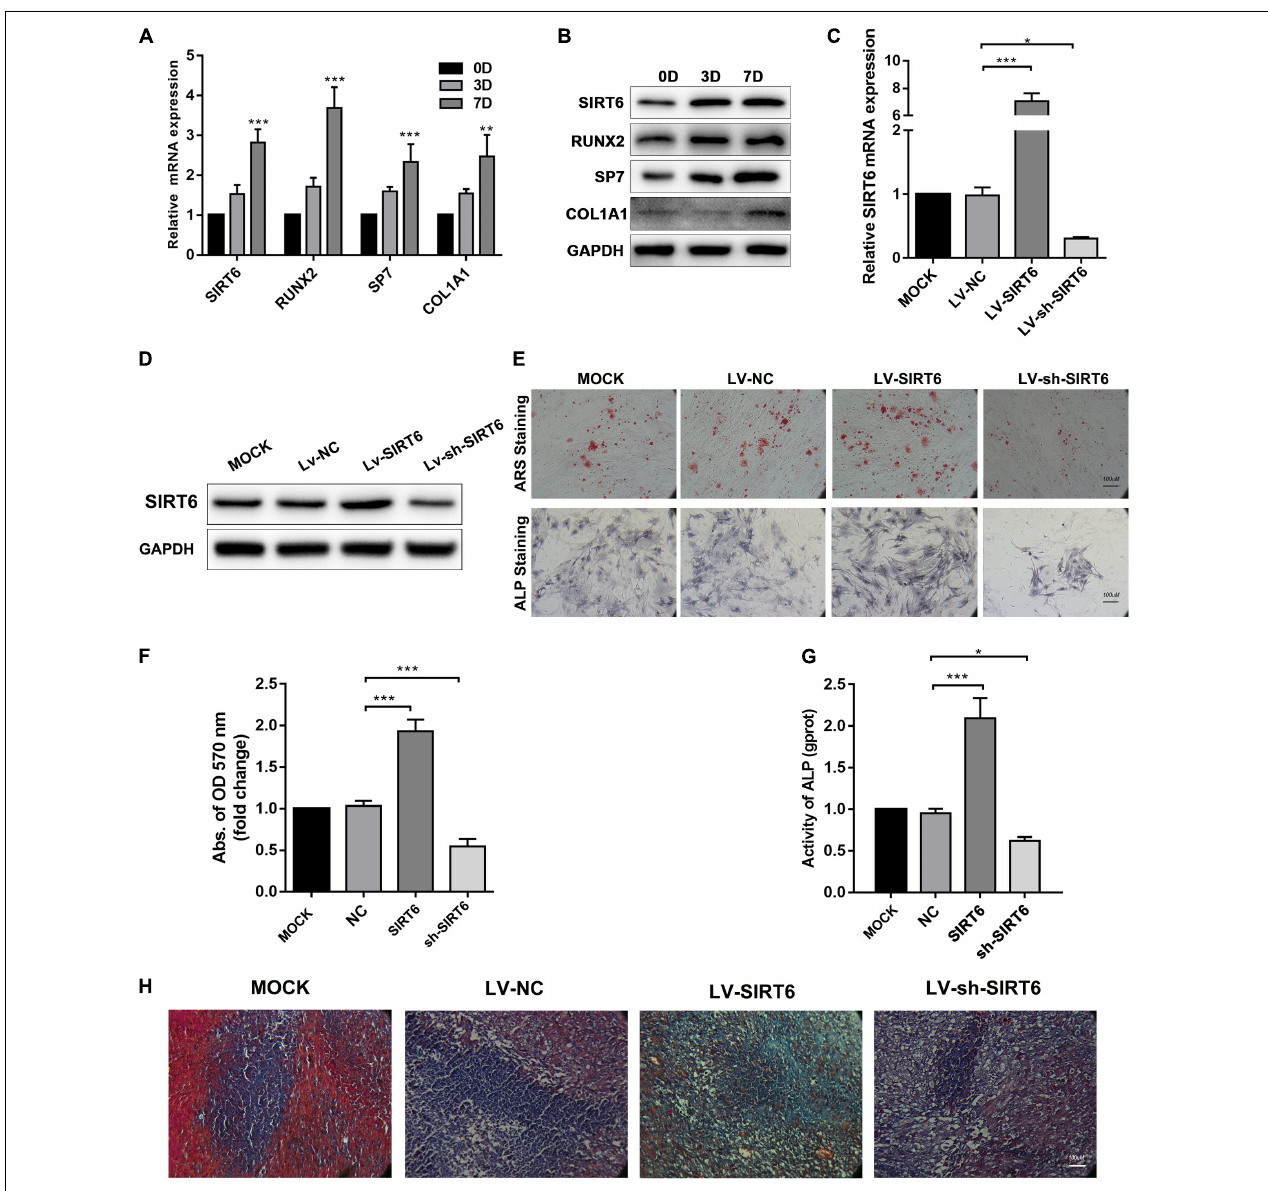
FIGURE 1 | SITR6 promoted osteogenic differentiation of hADSCs. (A,B) Relative expression of SIRT6, RUNX2, SP7, and COL1A1 during osteogenic differentiation of hADSCs at day 0, 3, 7, determined by RT-qPCR and Western blot. (C) RT-qPCR analysis of SIRT6 in overexpression or knockdown hADSCs. (D) Western blot analysis of SIRT6 in overexpression or knockdown hADSCs. (E) Images of Alizarin red staining and ALP staining in SIRT6 overexpressed or silenced hADSCs. Cells were cultured in osteogenic differentiation media for 14 days. Alizarin red staining was quantified by spectrophotometry (F) Activity of ALP (G) (normalized to the NC groups). (H) SIRT6 promoted the osteogenesis of hADSCs in vivo . hADSCs loaded on HA-TCP were transplanted into the dorsal region of nude mice for 4 weeks. Then, sections of transplants were stained by Masson’s trichrome. Data were shown as means ± SD. * p < 0.05, ** p < 0.01, *** p <